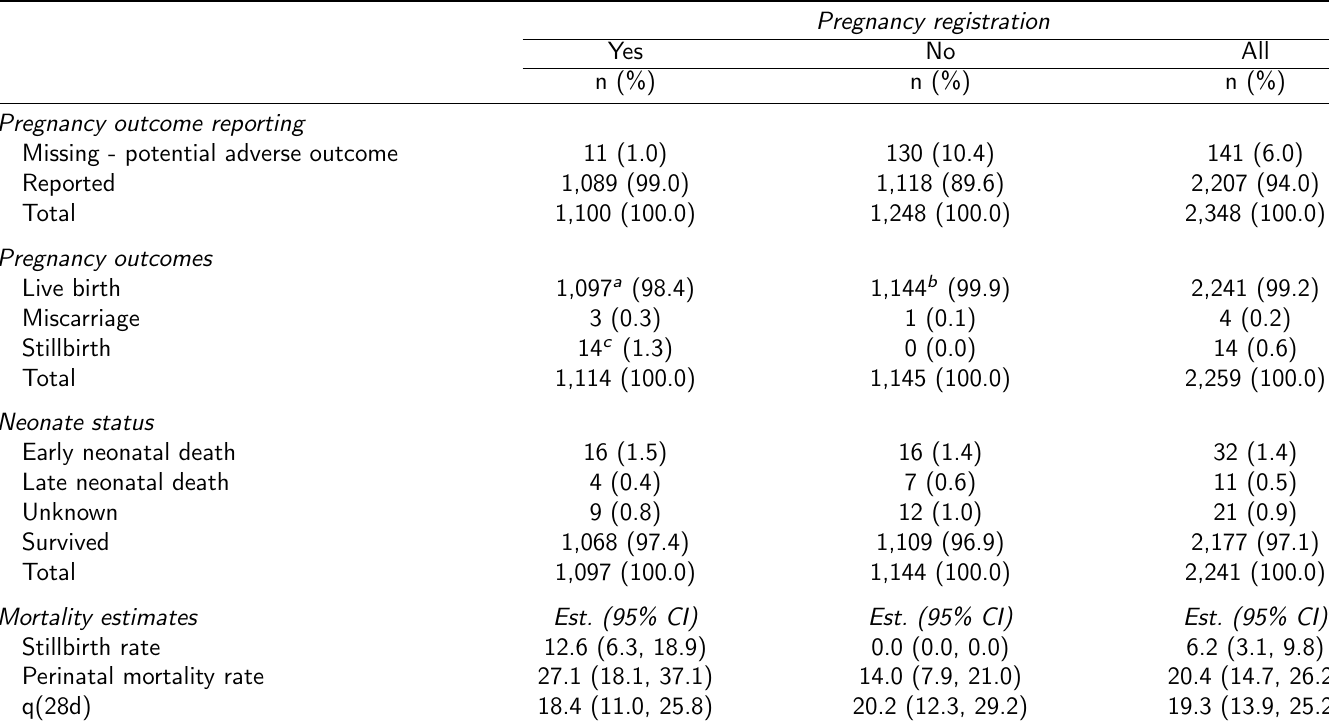
Table 1: Distribution of HDSS pregnancy reporting for women with linked ANC records